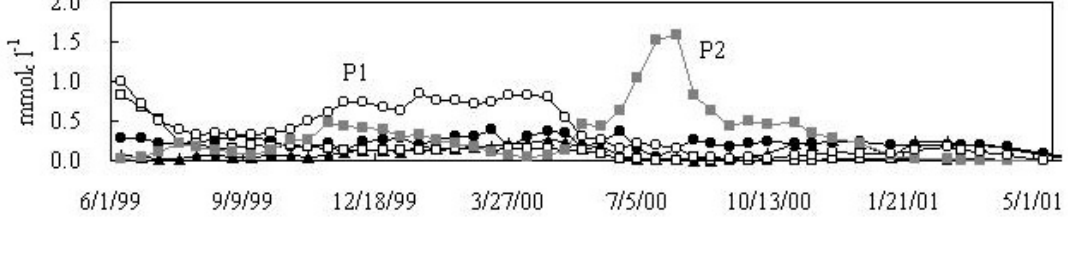
FIGURE 3. Temporal changes in nitrate concentration of soil solution at 20-cm depth at the no-manipulation areas in